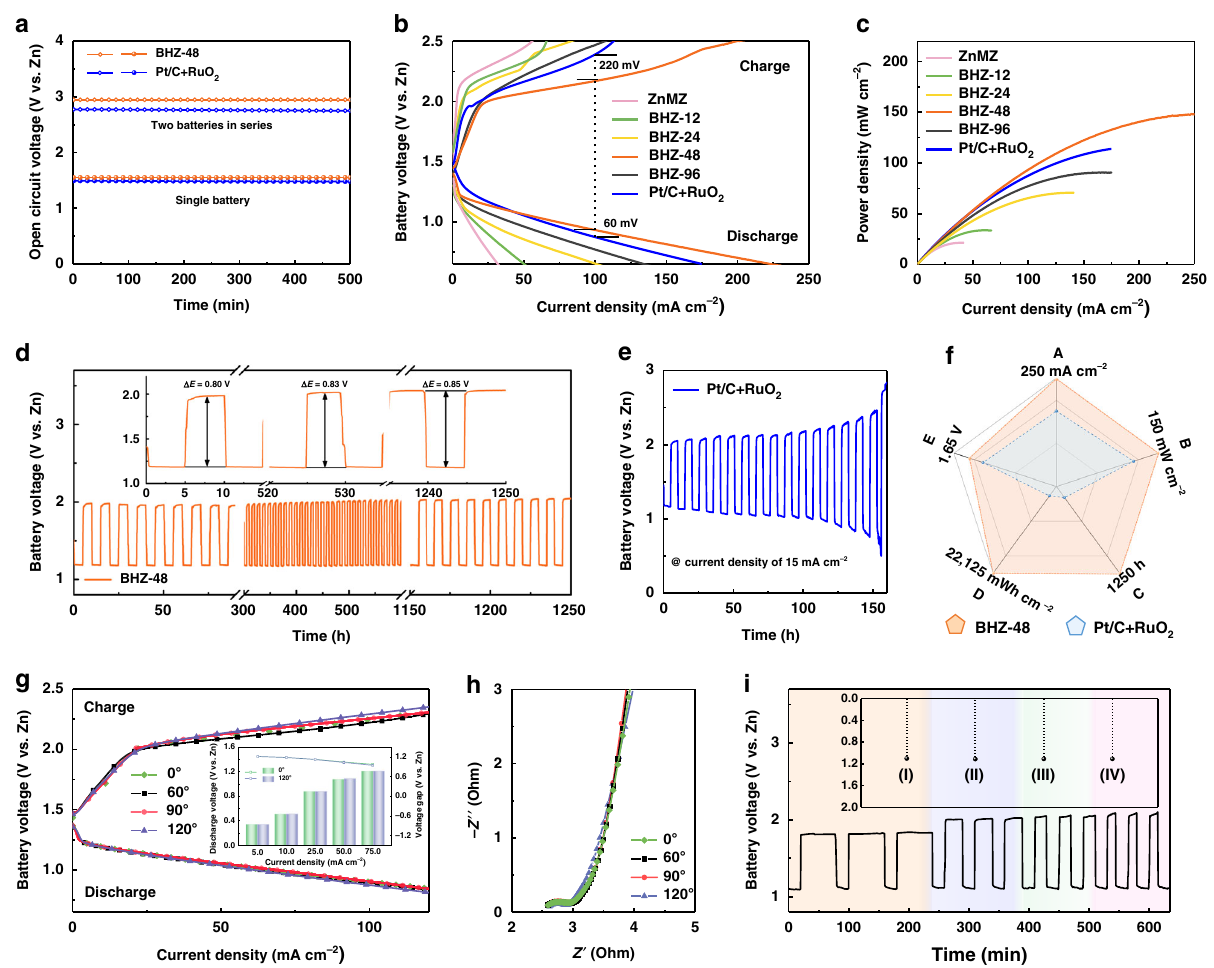
Fig. 4 Zn – air battery performance evaluation. a Open-circuit voltage curves, b charge and discharge polarization curves, and c corresponding power density plots for Zn – air battery prepared with BHZ-48 or Pt/C + RuO 2 electrodes. d Galvanostatic cycling stability of Zn – air battery prepared with BHZ-48 electrode, and e the Pt/C + RuO 2 electrode at a current density of 15 mA cm − 2 . f Comparison of key performance parameters for BHZ-48 and Pt/C + RuO 2 electrodes. A: current density; B: power density; C: lifespan, D: cumulative energy density; E: discharge voltage. g Charge and discharge polarization curves, inset: corresponding discharge voltages and voltage gaps. h Nyquist plots of the fl exible Zn – air battery prepared using the BHZ-48 electrode under different bending angles. i Alternating charging mode test, (I) 10 mA cm − 2 , 60 min, (II) 20 mA cm − 2 , 30 min, (III) 30 mA cm − 2 , 20 min, (IV) 40 mA cm − 2 , 15 min. Inset in i : average discharging voltage